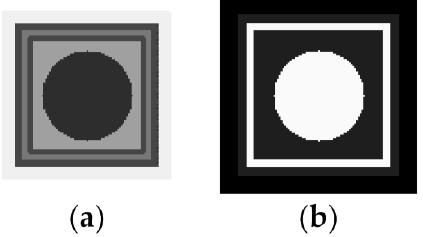
Figure 5. Chip template: ( a ) template for color picture; ( b ) template for coaxial